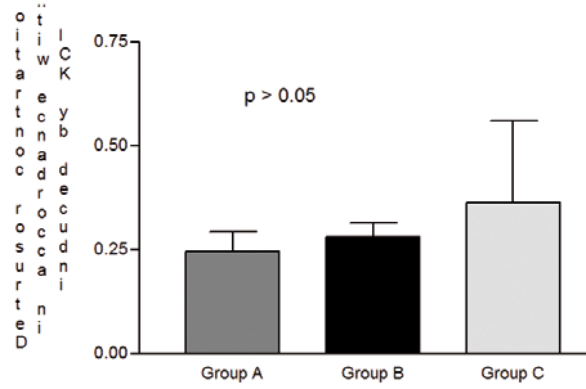
Figure 5 - Response of the detrusor musculature to ATP (10